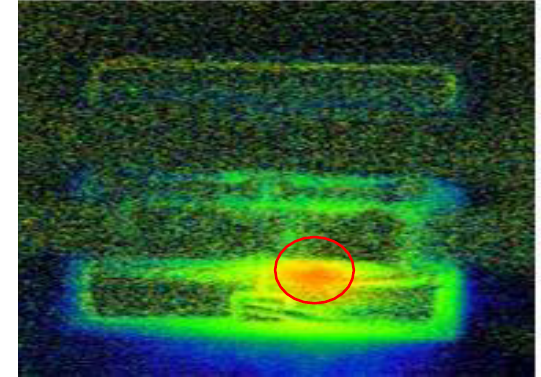
Fig. 8 . Phase image MOSFET transistor with thermal adjustment